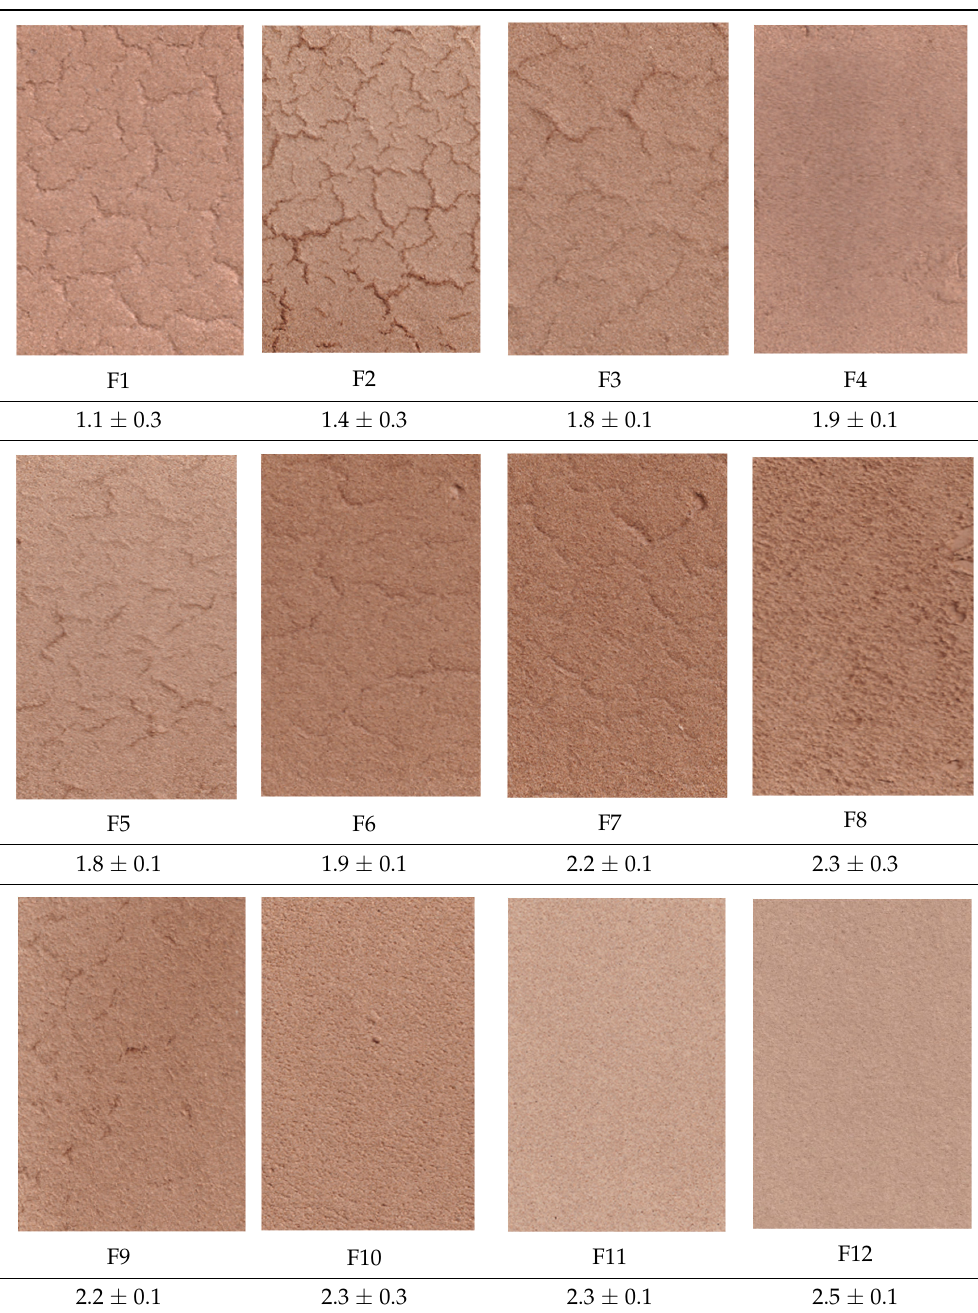
Table 3. Photographic images of composite acrylic/cork (cork:resin mass ratio = 1:10) applied on HDF surface. The values underneath each formulation identifier represent the average foam thickness in mm (measured only on the regions covered with foam) and the standard deviation of that